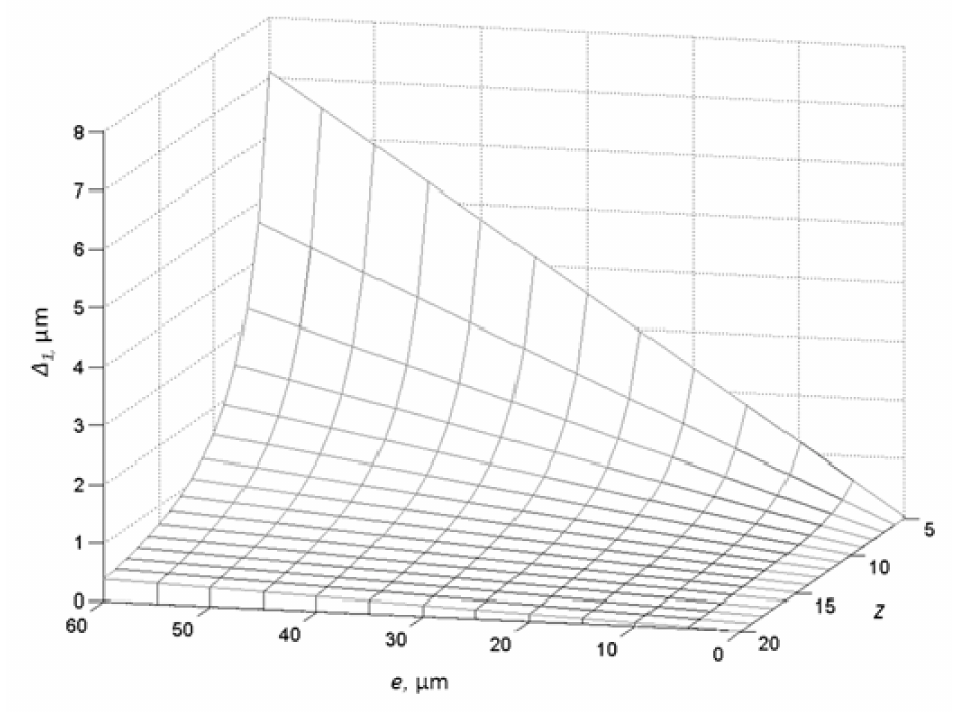
Figure 5. The vibrations amplitude of the unloaded rolling bearing depending on the size of the internal radial clearance and the total number of rolling